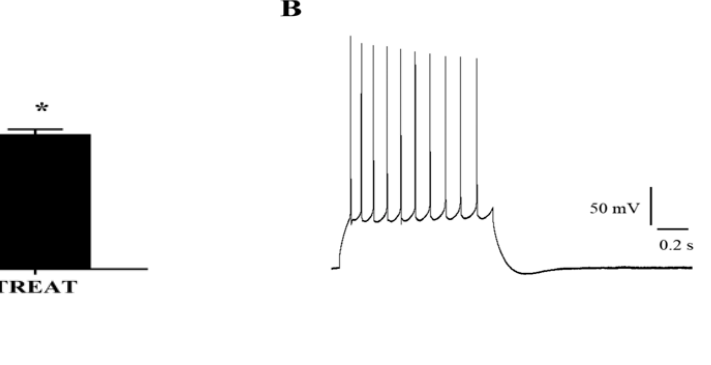
Nutrients 2019 , 11 , x FOR PEER REVIEW 8 of 13 from approximately − 70 to − 10mV). An afterhyperpolarization is observable following action potential burst. ( C ) Creatine supplementation reduces the afterhyperpolarization appearance in CA1 neurons. CTRL = 25 neurons; TREAT = 25 neurons. Fisher’s exact test: p = 0.012. CTRL = 5 rats; TREAT = 5 rats.